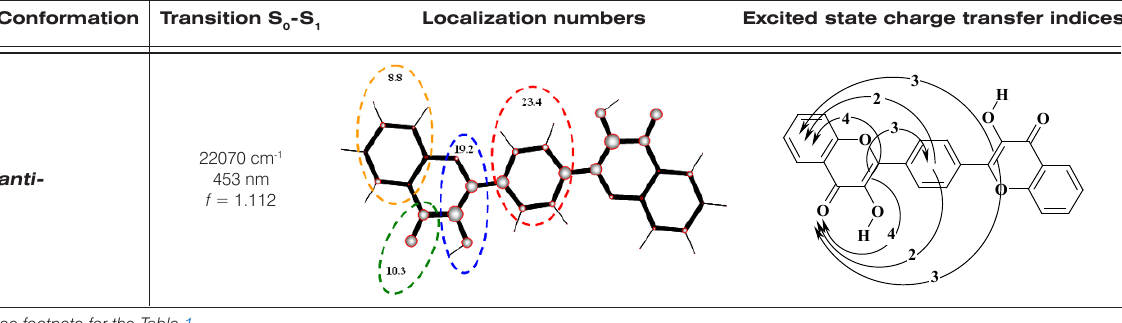
Table 2. Characteristics of the long-wavelength electronic transition in the molecule of the anti-conformer of bis-flavonol for the S geometry. Con for ma tion Transition S -S 0